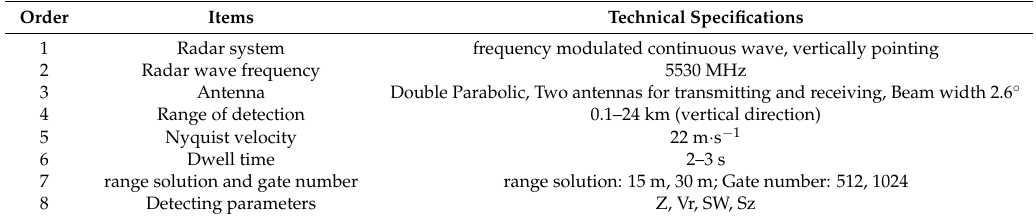
Table 3. Main technical parameters of the C-FMCW radar system.